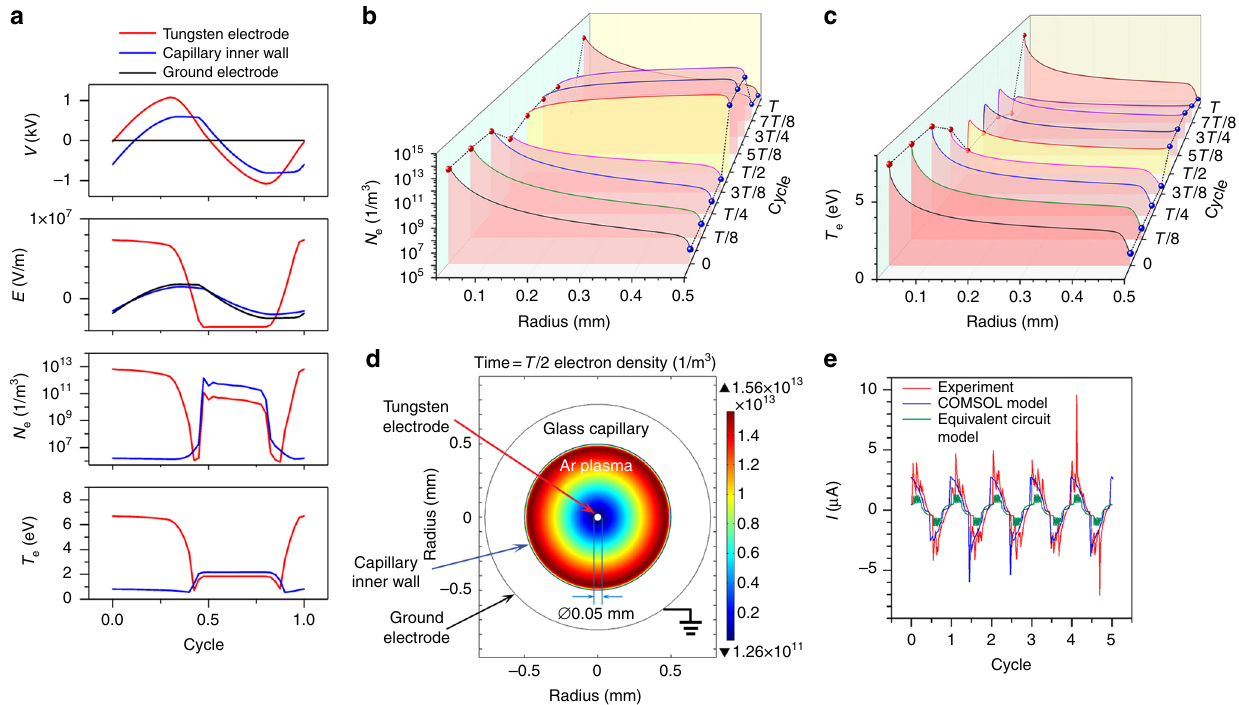
Fig. 3 Simulation of dielectric barrier discharge (DBD) capillary plasma. a The transient voltage, electric fi eld, electron density and electron temperature waveform with time at the points of tungsten electrode, capillary inner wall and ground electrode in one cycle, respectively. b , c Electron density and electron temperature pro fi les along the radius inside of capillary from tungsten to capillary inner wall at various typical time in one cycle. The value at the time of T /2 is highlighted by light yellow. d Time = T /2 (half of one cycle), electron density distribution in the cross section of the glass capillary with inner diameter of Ø1 mm and outer diameter of Ø1.54 mm. Diameter of tungsten wire electrode is Ø0.05 mm. Copper foil outside of capillary is grounded. The frequency f is 44 Hz. e Current waveforms of experiment, COMSOL model, and equivalent circuit